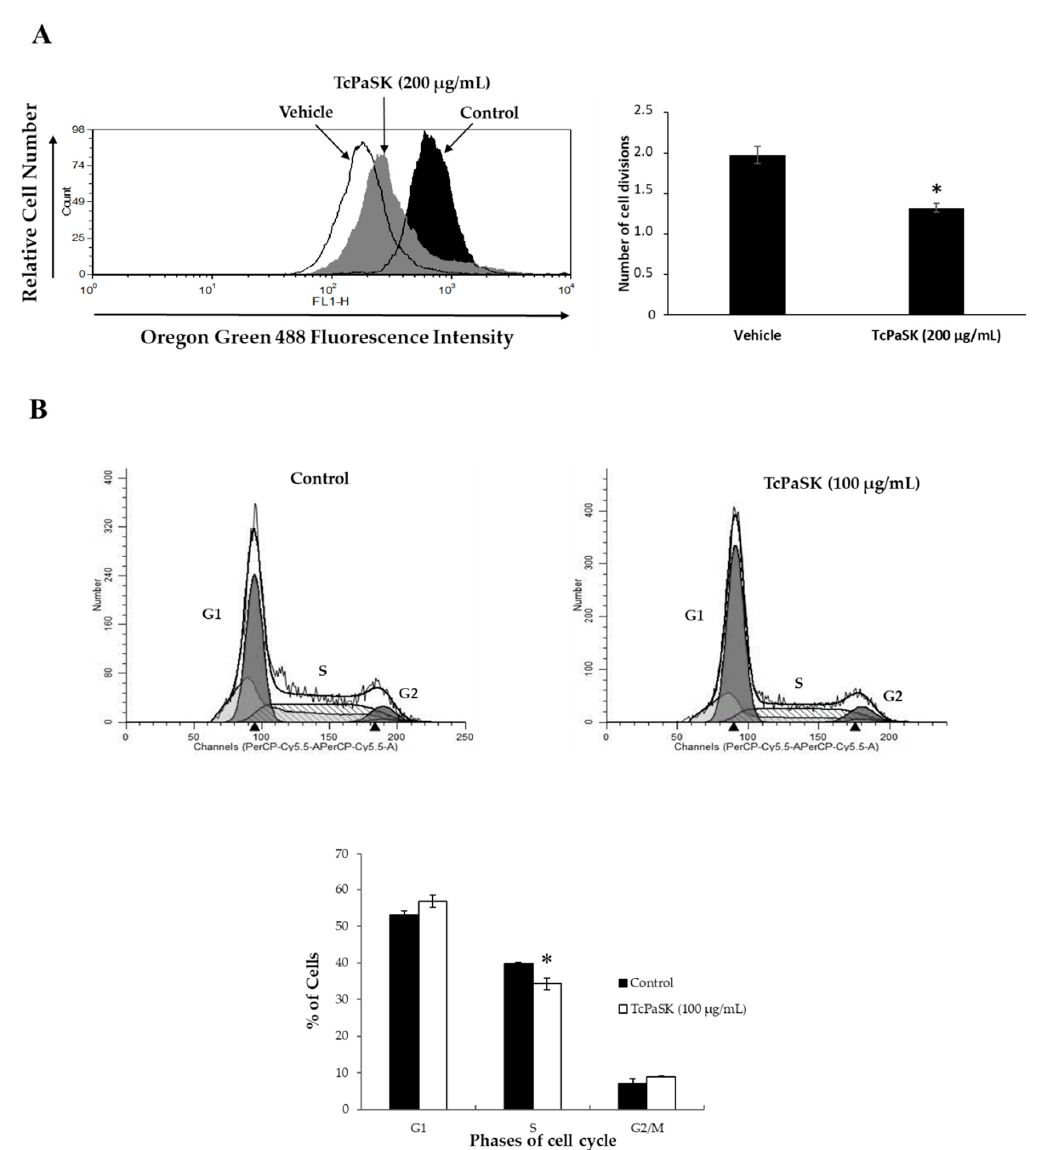
Figure 6. Antiproliferative effect of TcPaSK on MDA-MB-231 TNBC cells. ( A ) MDA-MB-231 TNBC cells were stained with Oregon Green 488 dye and cultured in the presence of medium, vehicle (water) or 200 μ g/mL TcPaSK for 72 h. Oregon Green-488 fluorescence was quantified by flow cytometry as a measure of cell proliferation and representative data are shown. The number of cell divisions was calculated, and data shown are the mean of at least 3 independent experiments ± SE. Asterisk indicates that differences between means of non-treated and TcPaSK-treated cells were statistically significant (Student’s t -test, p < 0.05). ( B ) MDA-MB-231 cells were cultured for 72 h in the absence or presence of 100 μ g/mL TcPaSK peptide, then stained with PI and analyzed by flow cytometry to determine cell distribution among three major phases of the cell cycle (G1, S and G2/M). Representative histograms are shown. Data represent the mean ± SE of at least 3 independent experiments. Asterisks indicate that differences between means of non-treated and TcPaSK-treated cells were statistically significant (Student’s t -test, p < 0.05).